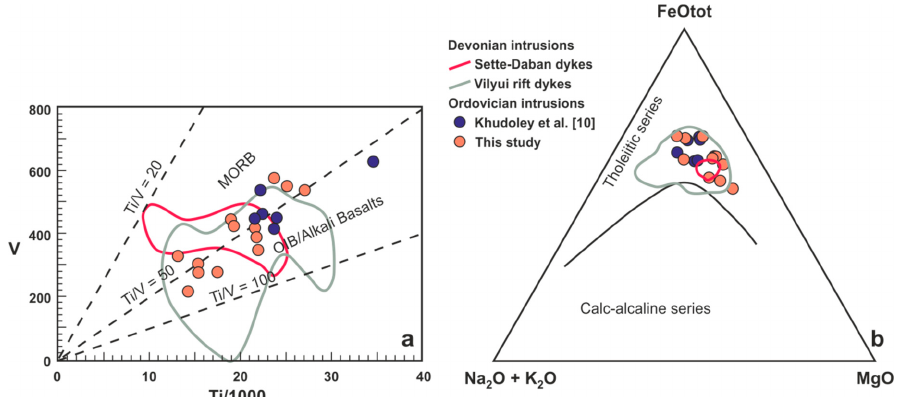
Figure 8. Discrimination diagrams for the Suordakh event mafic intrusions cutting the Gornostakh Anticline [10] and those cutting the Cambrian units as well (this study). ( a ) Ti vs. V [46], ( b ) Na 2 O + K 2 O–FeOtot MgO [47]. Fields of the Devonian Sette-Daban dykes and Vilyui rift dykes are shown for comparison after [29,45]. On both diagrams, the composition fields of the Ordovician and Devonian intrusions overlap each other.